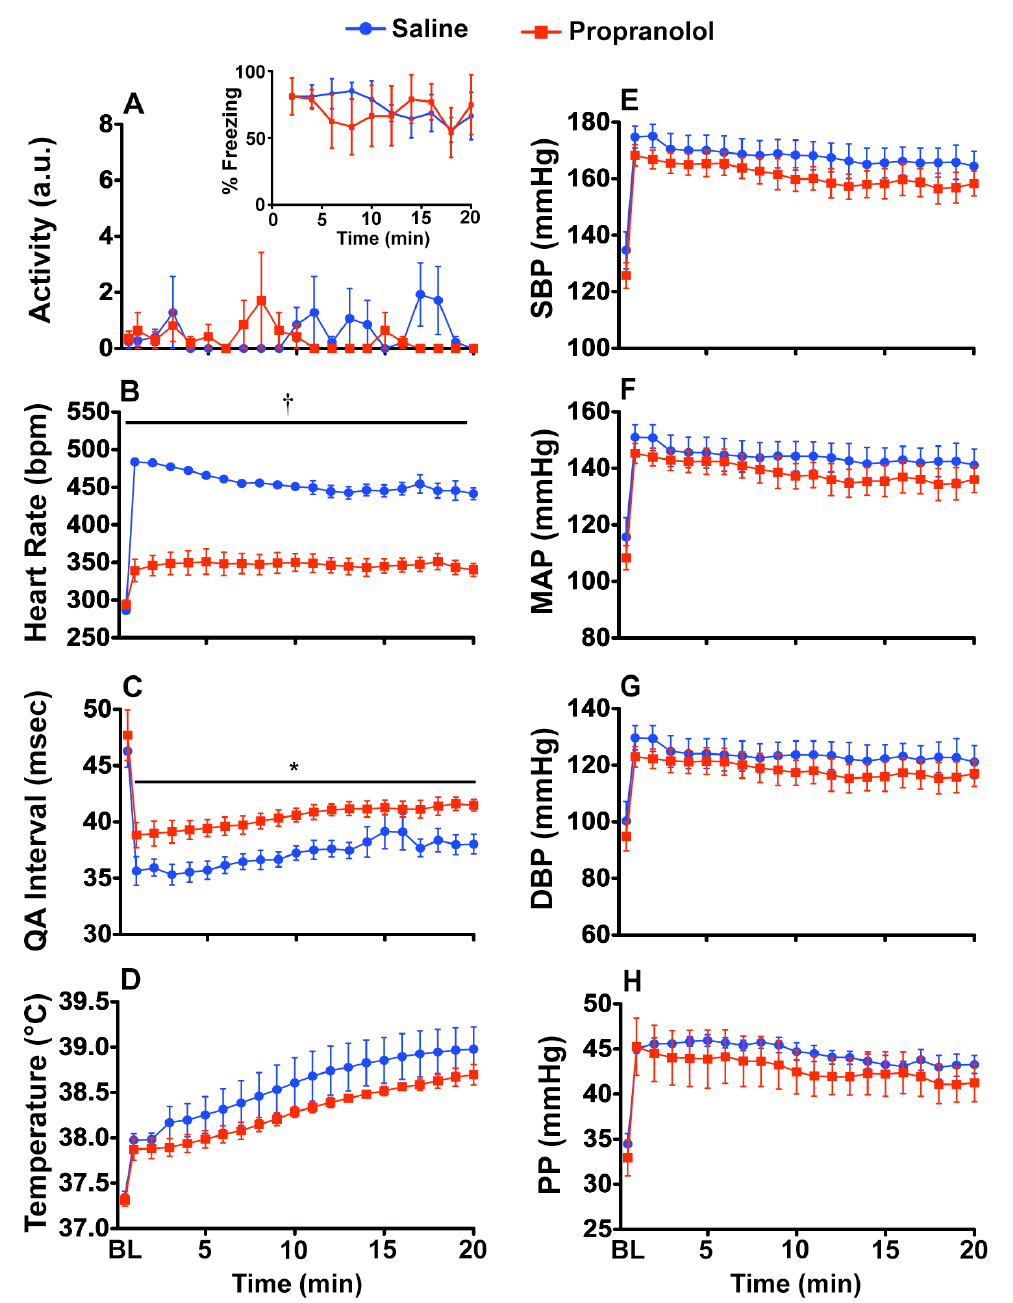
Figure 3. Propranolol (5.0 mg/kg) blocks fear-evoked increases in heart rate. In vivo telemetry responses during acute CFT. Rats were either injected ip with saline or propranolol 10 min before exposure to the conditioned context. ( A ) Propranolol had no effect on freezing behavior (inset) or locomotor activity. Pre-shock baseline levels of freezing ranged between 0–5% (data not shown); ( E – H ) Propranolol had no effect on blood pressure during exposure to the CFT; ( B ) Heart rate was decreased in propranolol injected rats; ( C ) The QA interval was significantly increased; ( D ) There was no effect of propranolol on body temperature. Abbreviations are as follows: baseline (BL), arbitrary units (a.u.), systolic blood pressure (SBP), mean arterial pressure (MAP), diastolic blood pressure (DBP), pulse pressure (PP). (* p < 0.05, † p <